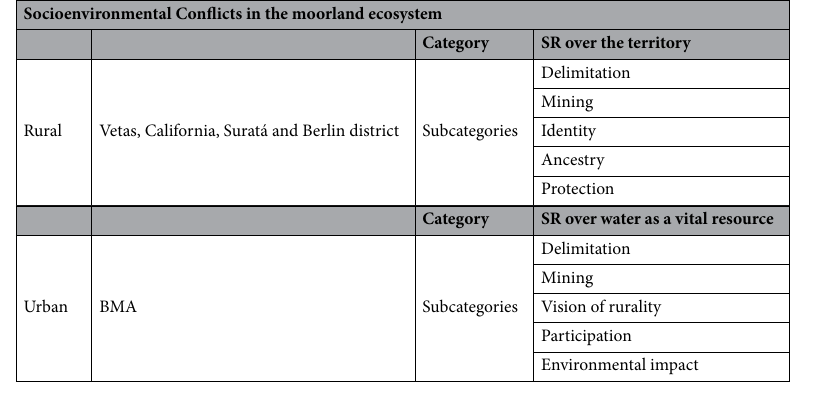
Table 3. Categories